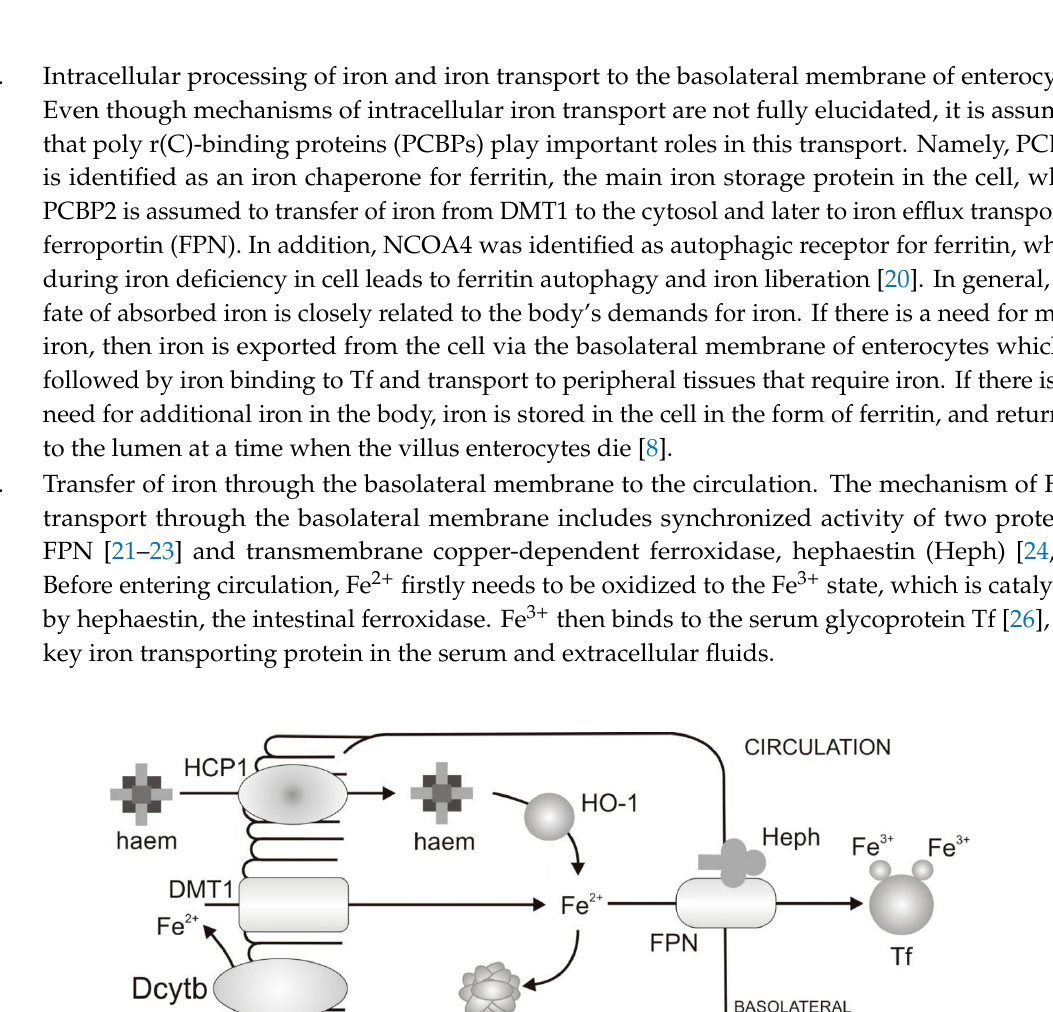
Table 1. Daily requirements of absorbed iron in individuals of different age, sex and state [32,33].